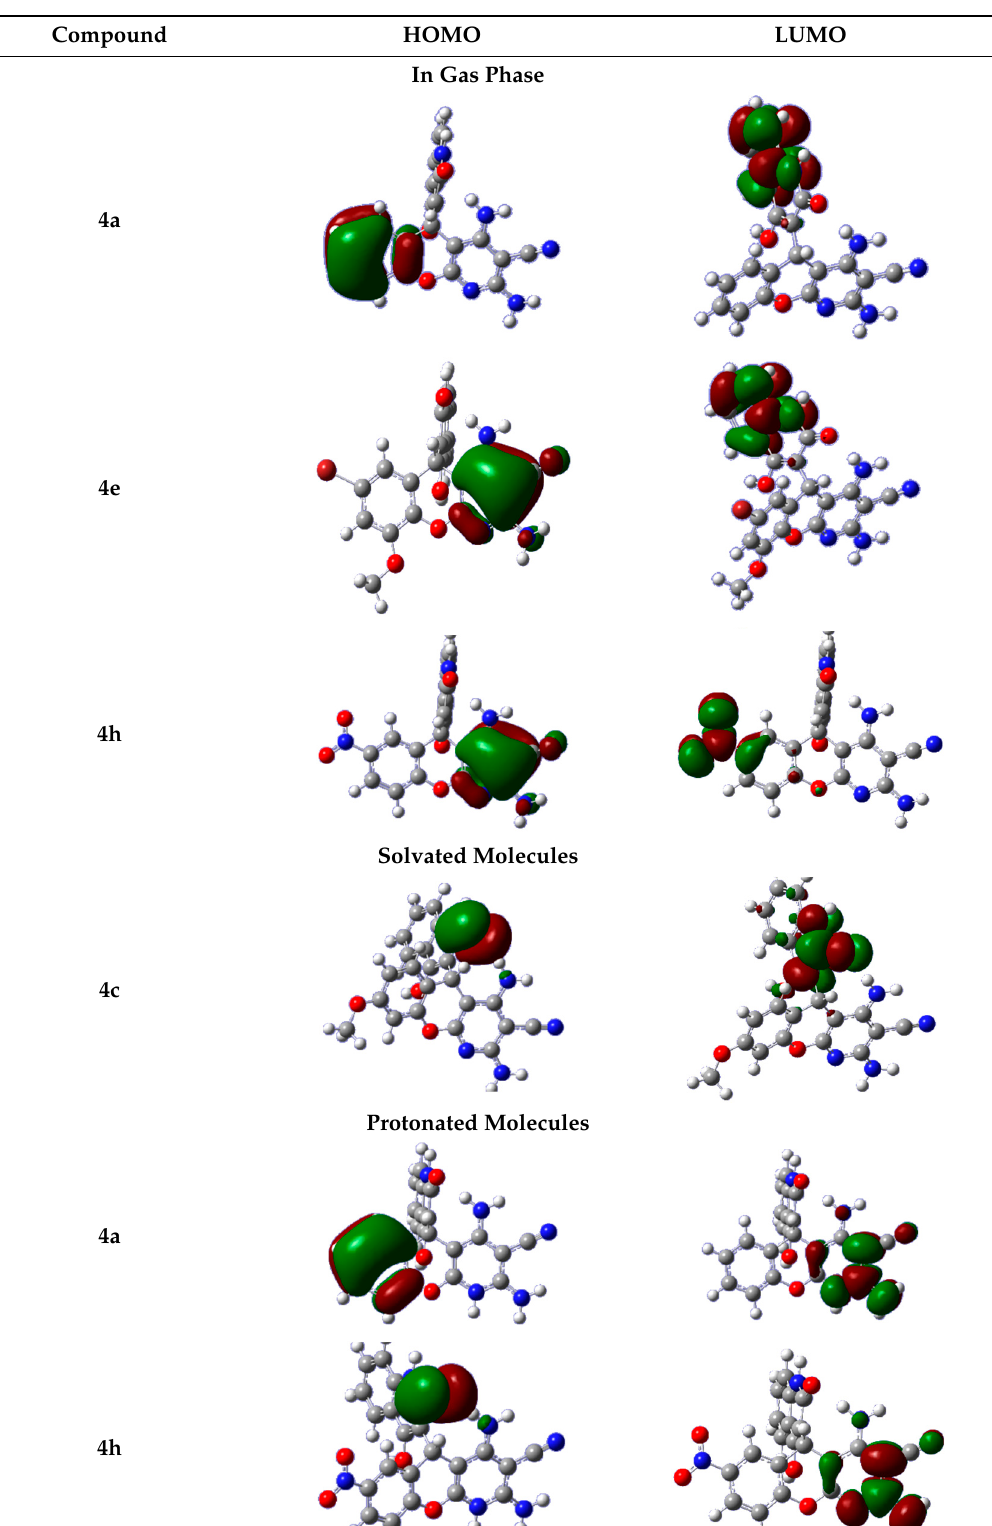
Table 4. Frontier orbitals of several studied compounds.